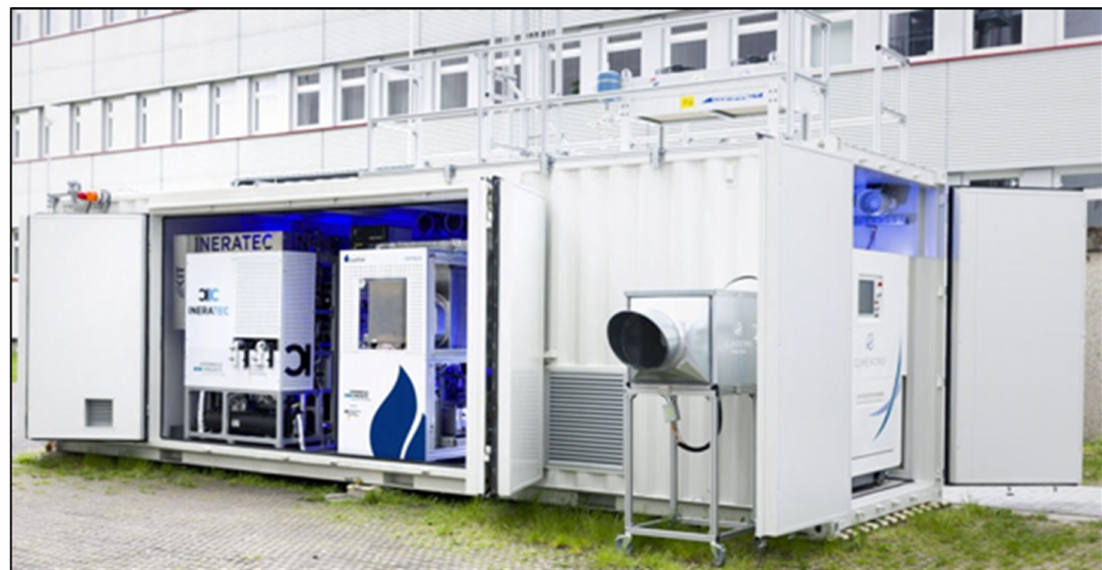
Figure 4. Container facility for the production of synthetic fuel at KIT